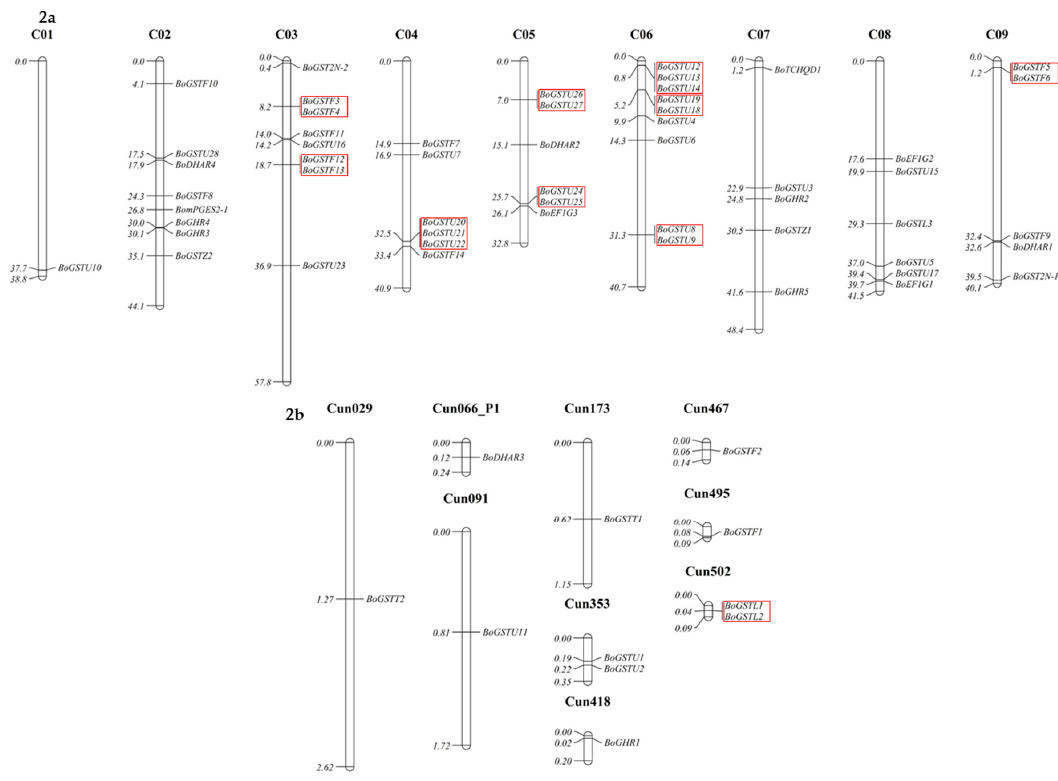
Figure 2. Chromosomal distribution of GST genes in B. oleracea genome plotted using Mapchart software. The red box indicates genes that are clustered within their GST class.